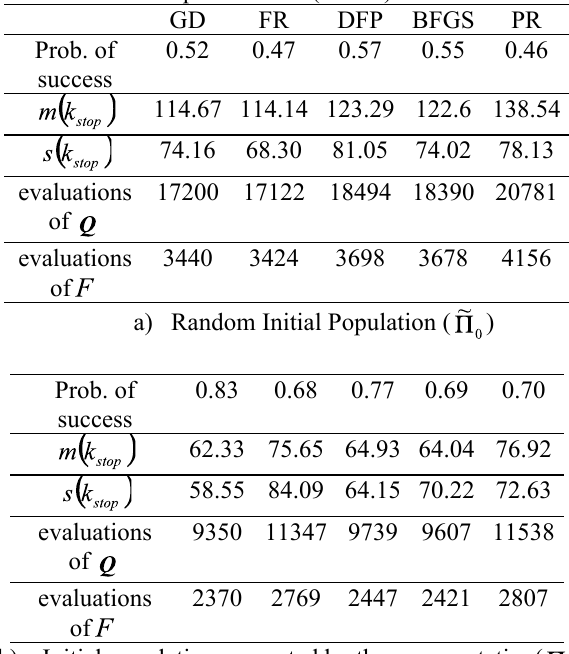
Table 3 – Rastringin’s function ( n = 5 , RPOP) – no random